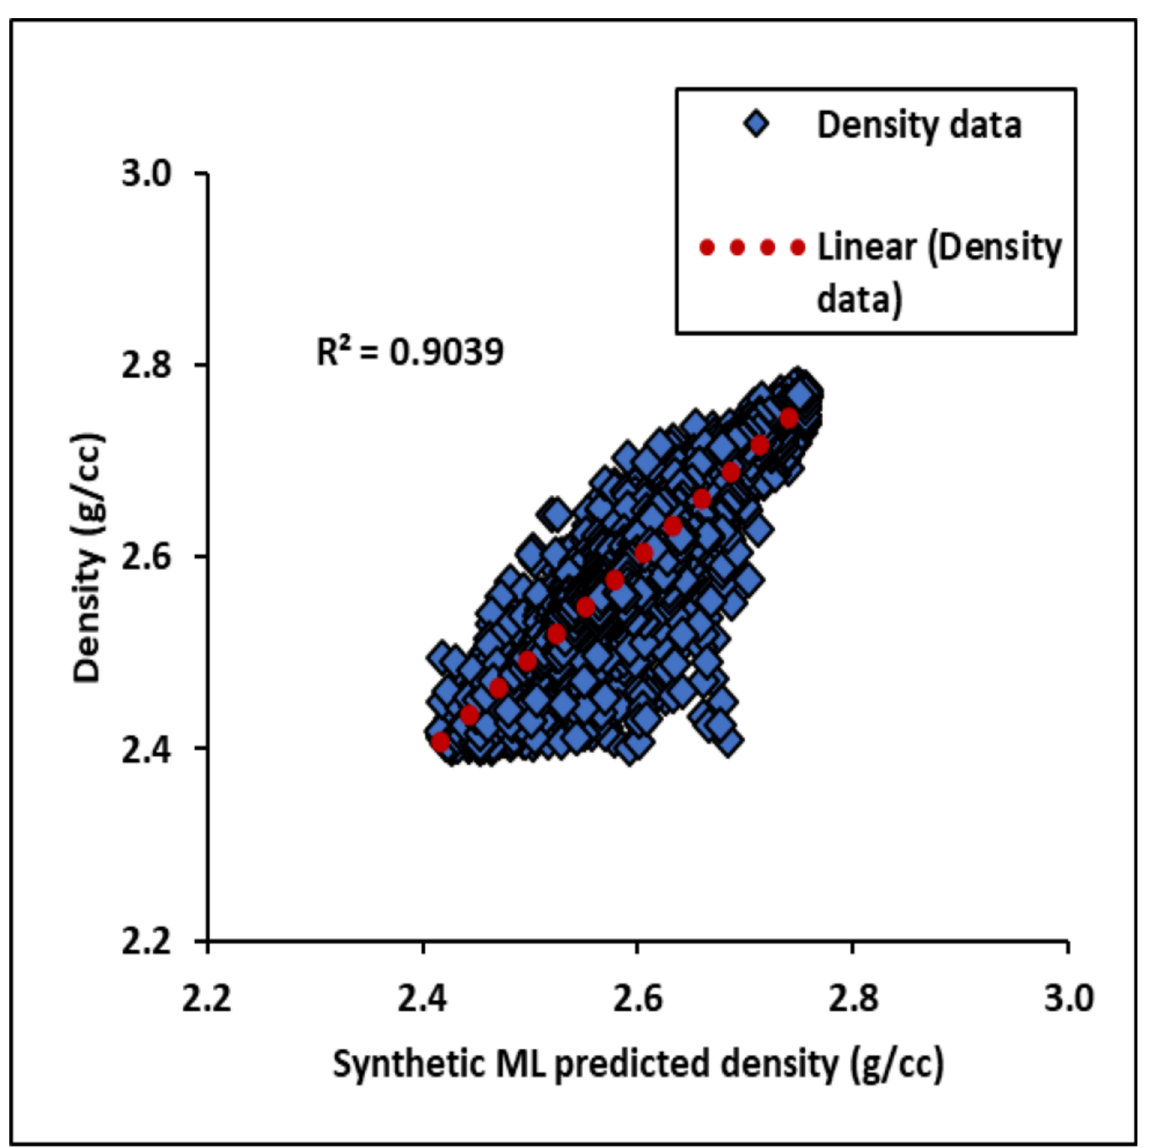
Figure 9. Cross ‐ plot of the measured bulk density and ML predicted density on the studied wells of the Goldwyer formation. The linear regression trend line (red) is overlaid on the plot. R 2 value of 0.90 between measured and predicted density is achieved.